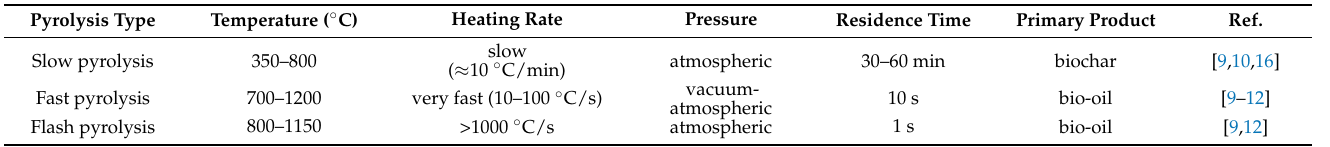
Table 4. Pyrolysis types and operating conditions.